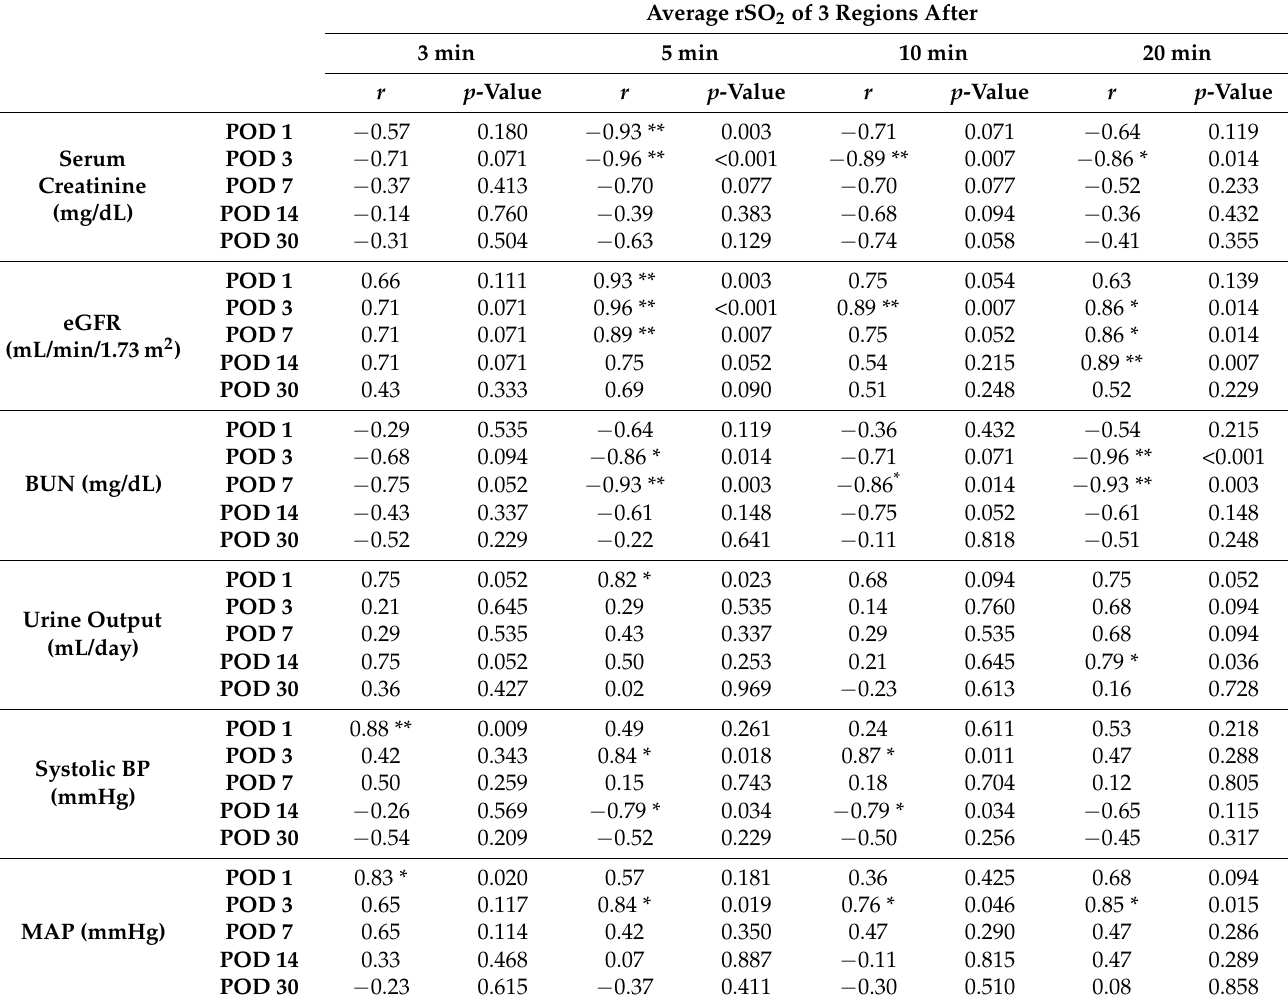
Table 4. Correlation of averaged tissue oxygen saturation (rSO 2 ) levels measured at three regions (upper pole, renal hilum, and lower pole) of the kidney allograft with renal function and hemodynamic parameters before and after renal